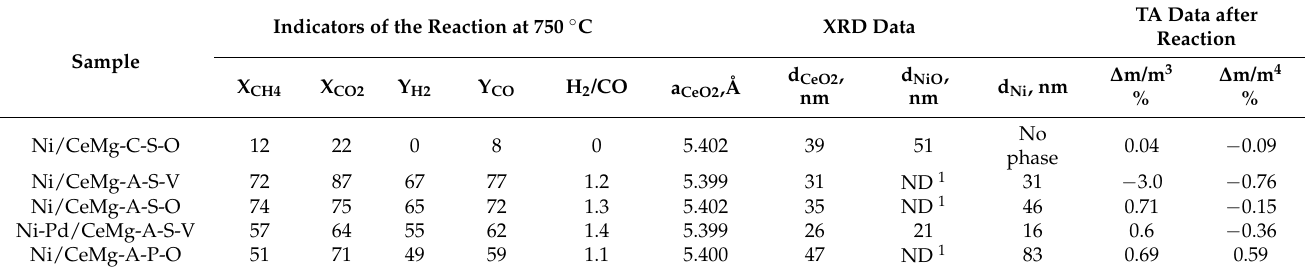
Table 5. Initial activity in CSMR at 750 ◦ C, XRD and thermal analysis data after 24 h on stream in CSMR at 750 ◦